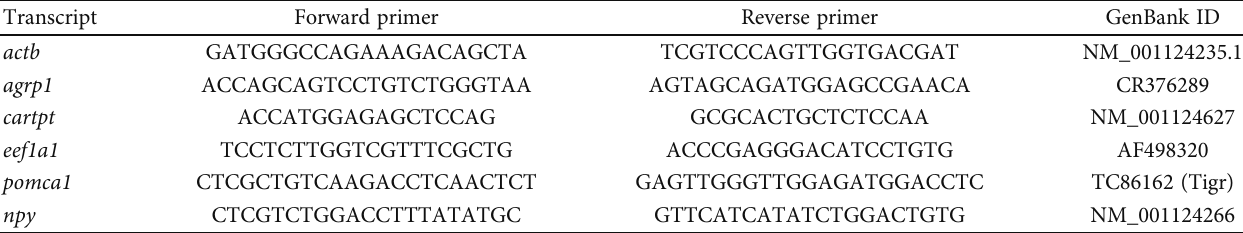
Table 1: Primer sequences used to evaluate mRNA abundance by quantitative RT-PCR (qPCR).